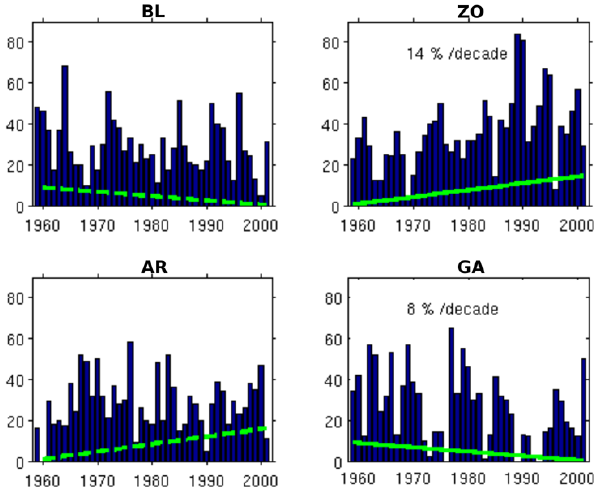
Fig. 4. Trends in the frequencies of observed LAR for the 45years of the ERA-40 reanalysis (1958–2002). As before first row, BL (left), ZO (right), second row, AR (left), GA (right).